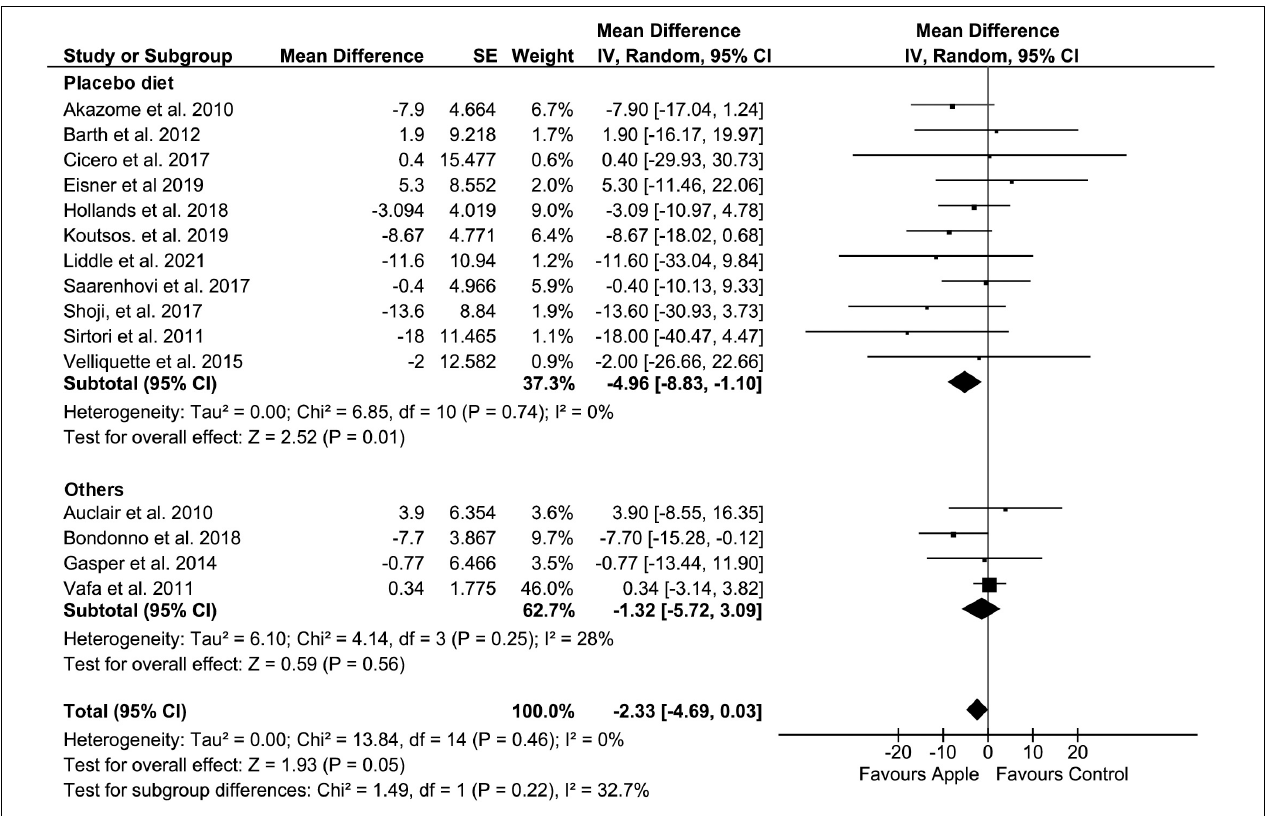
FIGURE 2 | Meta-analysis results of total cholesterol. Forest plot is stratified by placebo diet or other alternative